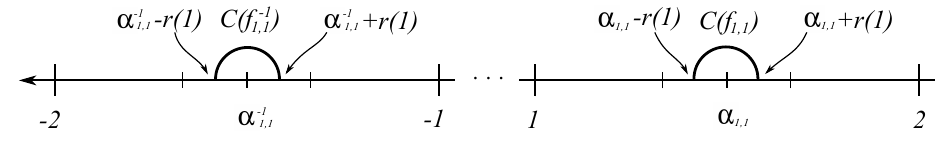
Figure 9: Half-circles C ( f 1,1 ) and C ( f −1 1,1 ) .